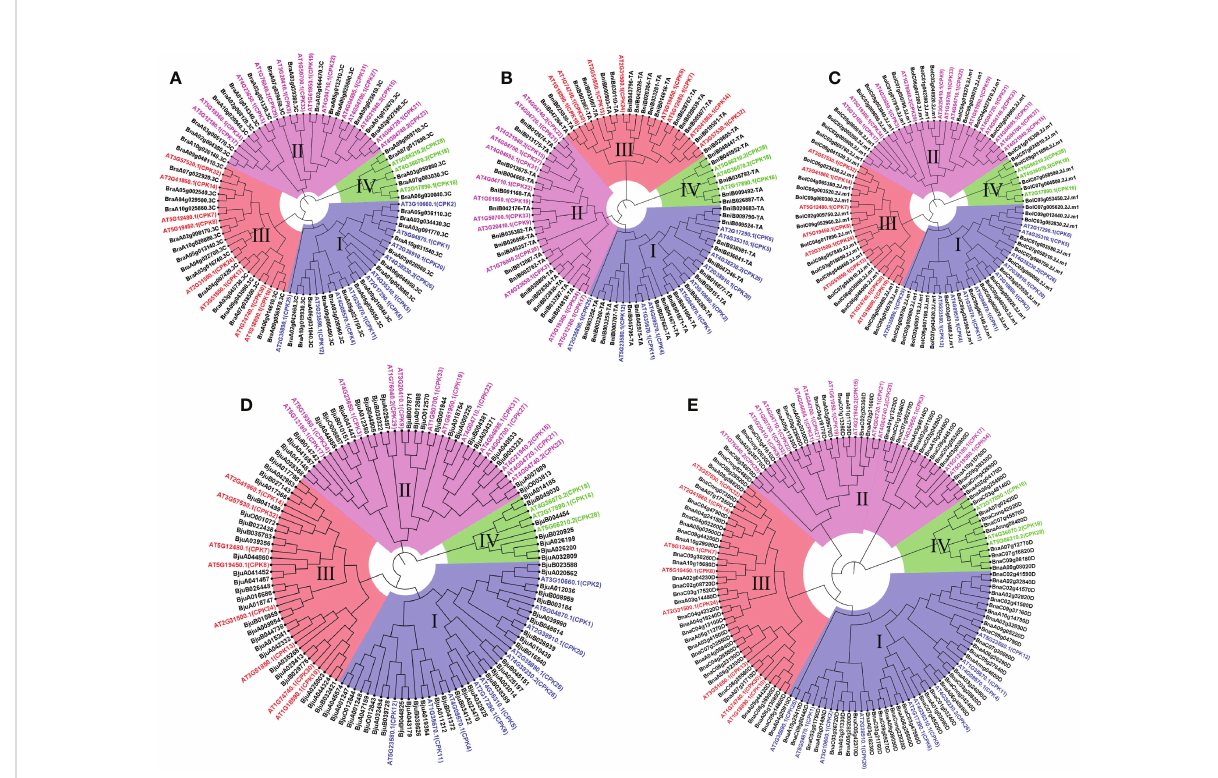
FIGURE 3 Phylogenetic trees of CPK proteins in fi ve Brassica species. Phylogenetic trees of CPK proteins in A. thaliana and B. rapa (A), B. nigra (B) , B. oleracea (C) , B. juncea (D) , B. napus (E) , respectively. The phylogenetic trees were generated by the NJ method with bootstrap analysis (2,000 bootstrap replicates) using an amino acid sequence alignment of CPK proteins from A. thaliana and Brassica species by the MEGA 11.0 program. The CPK proteins in each Brassica species were clustered into four groups (group I, group I, group III, and group